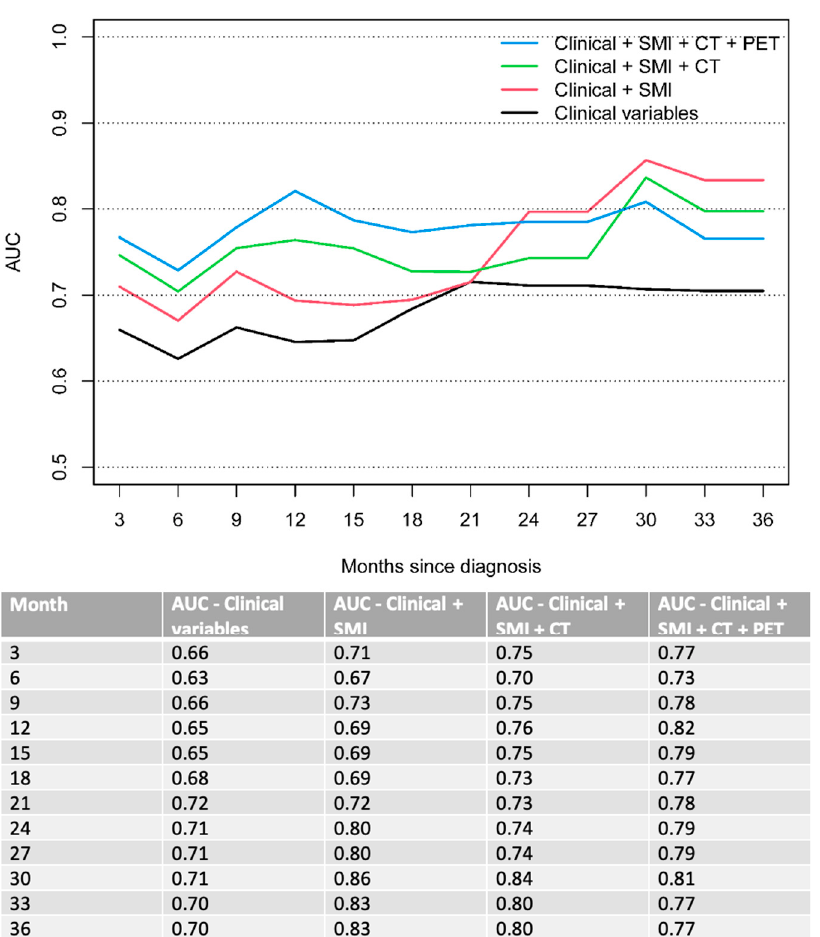
Figure 3. Time-dependent AUC for PFS. Clinical variables include ECOG performance status and bone metastases.